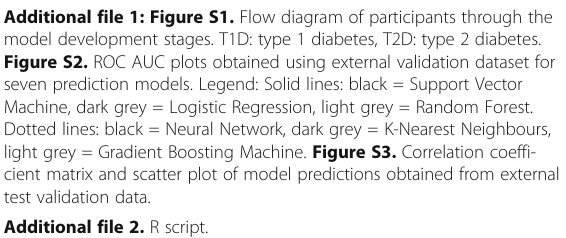
Additional file 1: Figure S1. Flow diagram of participants through the model development stages. T1D: type 1 diabetes, T2D: type 2 diabetes. Figure S2. ROC AUC plots obtained using external validation dataset for seven prediction models. Legend: Solid lines: black = Support Vector Machine, dark grey = Logistic Regression, light grey = Random Forest. Dotted lines: black = Neural Network, dark grey = K-Nearest Neighbours, light grey = Gradient Boosting Machine. Figure S3. Correlation coeffi- cient matrix and scatter plot of model predictions obtained from external test validation